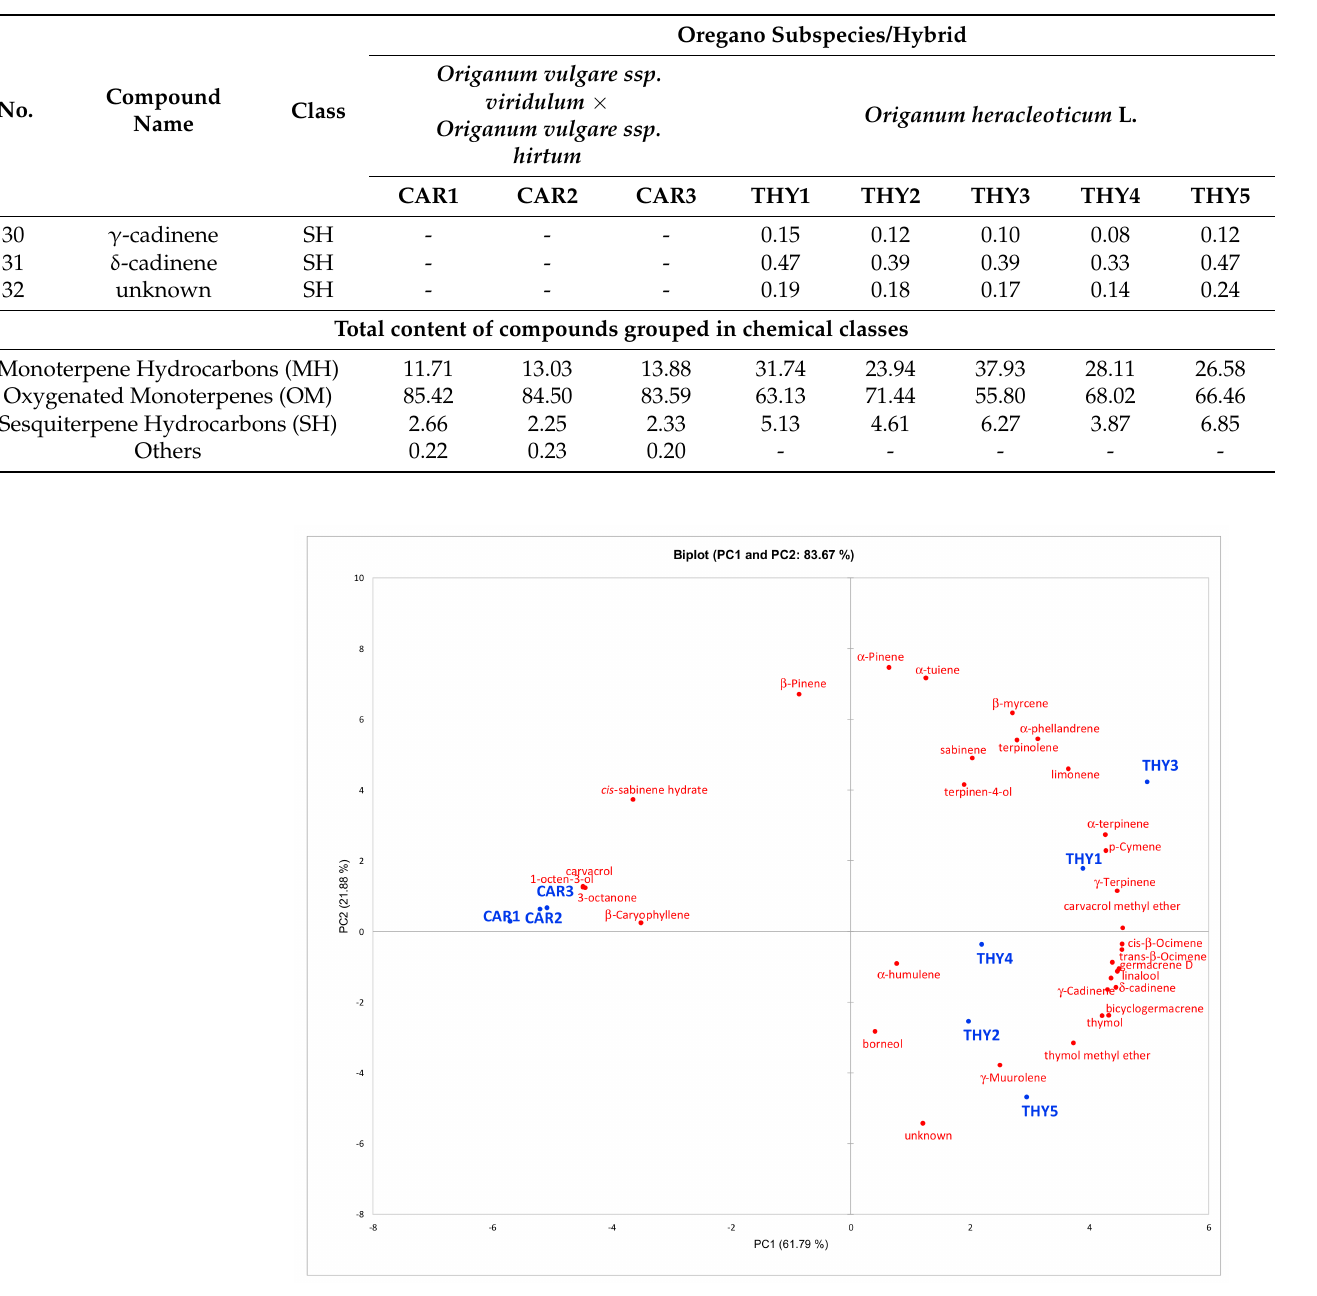
Figure 1. Principal component analysis (PCA) biplot of the first two PCs obtained in the dataset of the chemical compositions of EOs of the hybrid Origanum vulgare ssp. viridulum × Origanum vulgare ssp. hirtum (CAR1, CAR2, CAR3) and of the subspecies Origanum heracleoticum L. (THY1, THY2, THY3, THY4,